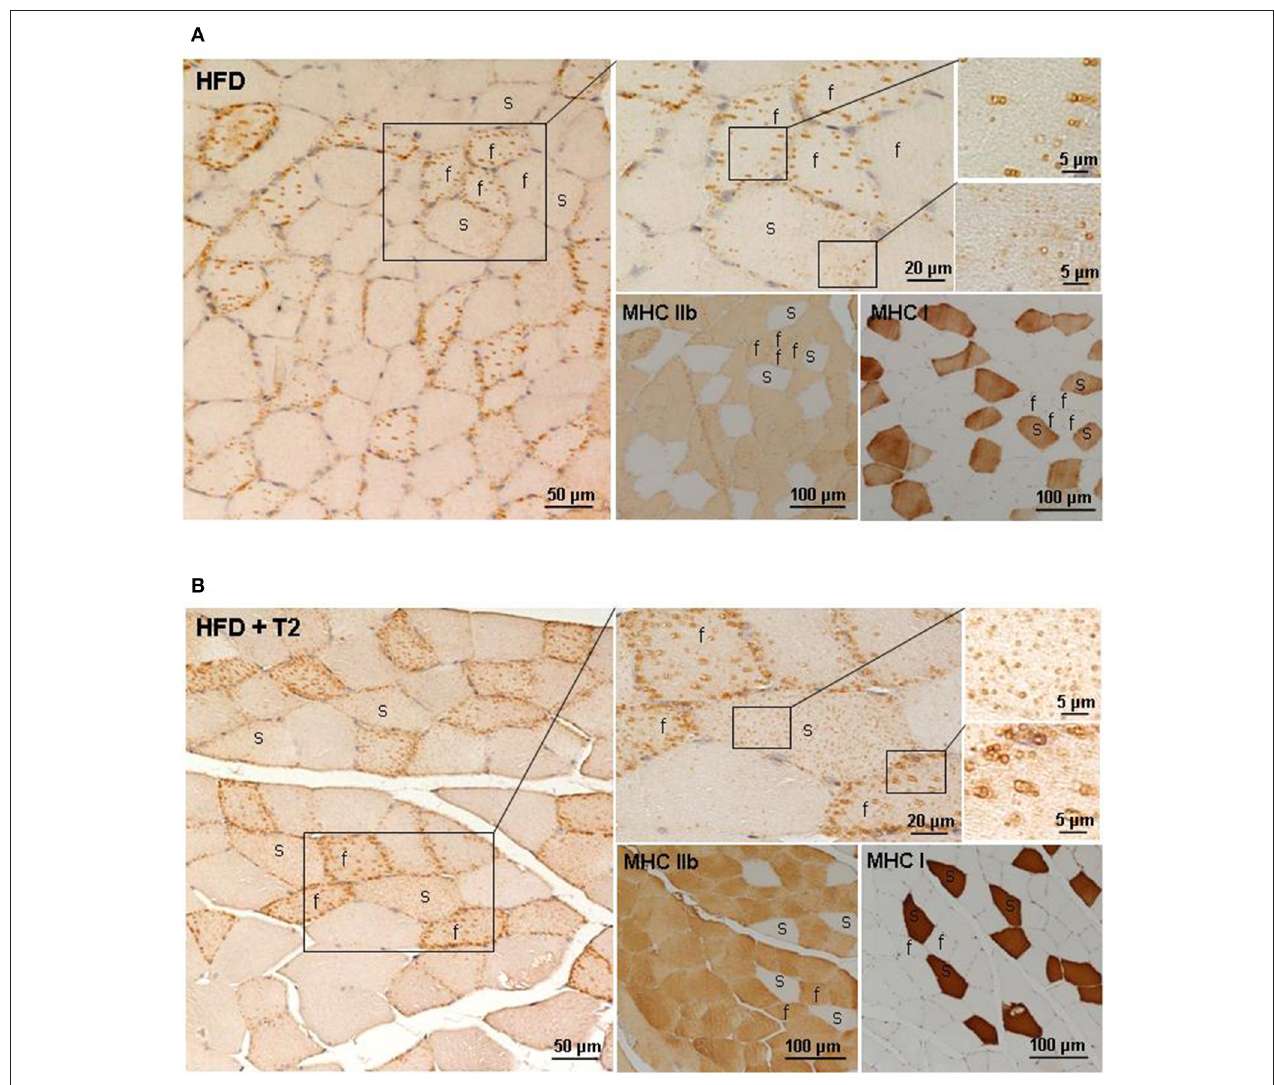
FIGURE 7 | Fiber type-specific ADRP immunoreactivity in gastrocnemmius muscle of HFD and HFD + T2 rats. ADRP immunohistochemistry in gastrocnemius muscle of HFD (A) and HFD + T2 (B) rats. Fiber type-specific ADRP-immunoreactive lipid droplets were obtained using adjacent serial sections (4 µ m-thick) to stain ADRP, MHC Ib, and MHC IIb proteins. Distribution of ADRP protein around LDs in a fast (f) and slow (s) fiber was shown by a higher magnification of the same framed area. In HFD rats, ADRP immunolabeling coated some but not all LDs, both in fast and slow fibers; in HFD + T2 rats, all small LDs (in slow fibers) and large (in fast fibers) lipid vacuoles showed an intense